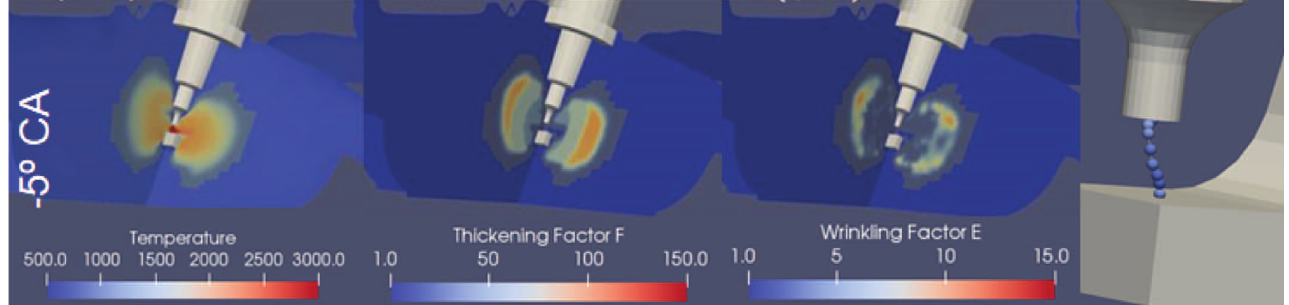
Fig. 13. TFM and LESI ignition model, from left to right: iso-contours of temperature (in K), iso-contours of the thickening factor F , iso-contours of the wrinkling factor N , and arc shape as predicted by LESI model at (cid:2) 5 (cid:3) CA aTDC. The yellow shading denotes the fl ame front as identi fi ed by the TFM sensor.